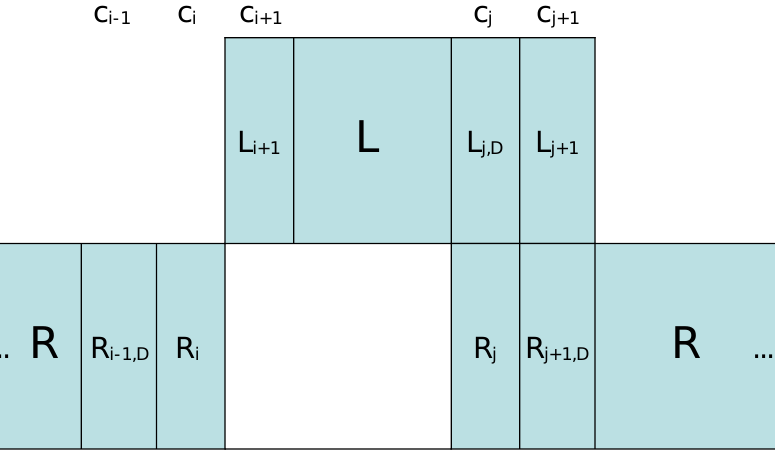
Figure 8 . c i (cid:0) 1 is placed adjacent to c i as a